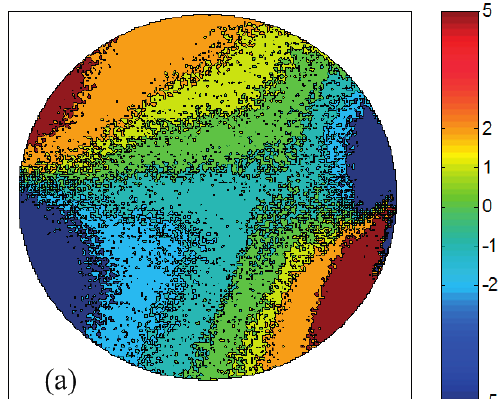
deviations of the polarization angle and the degree of